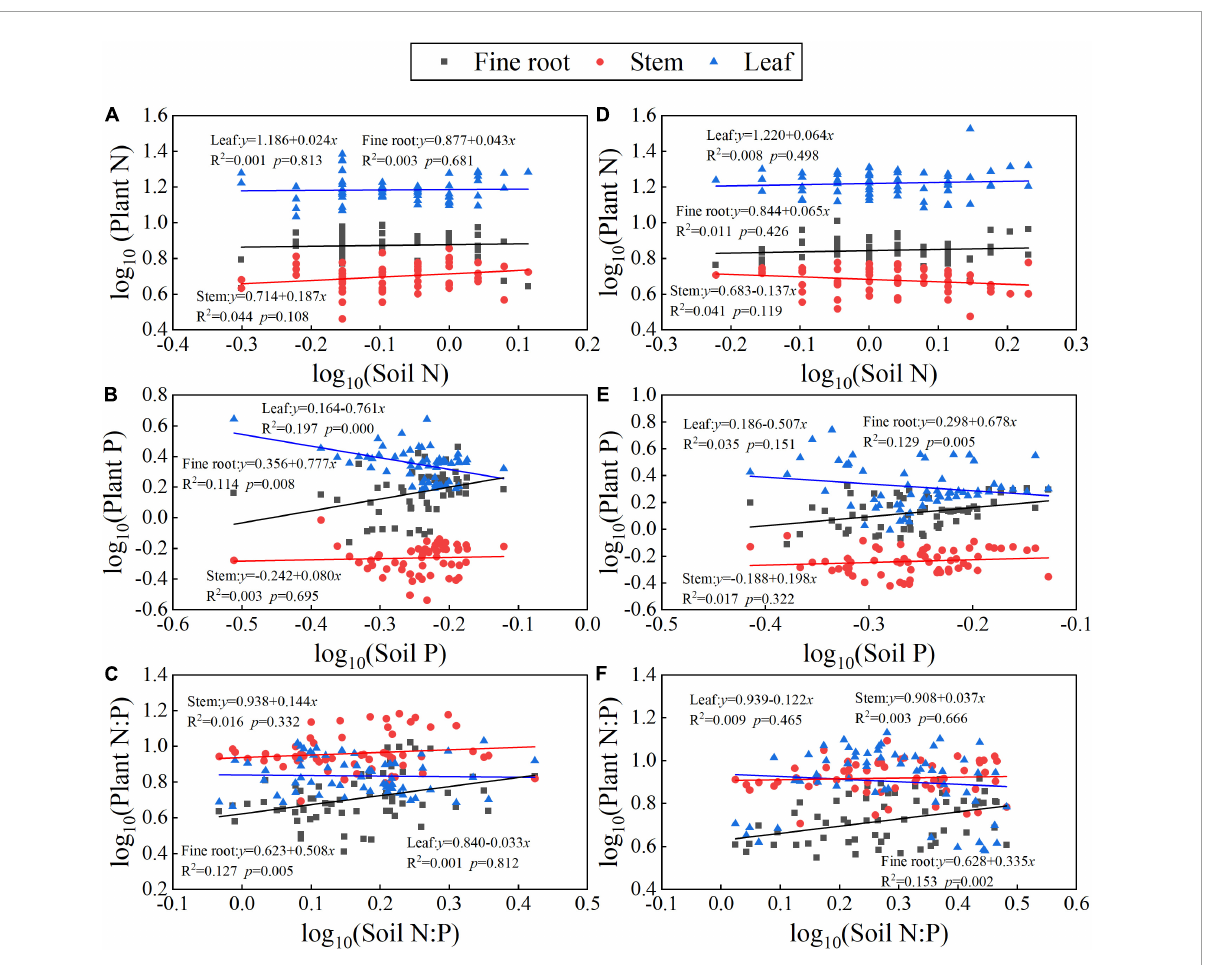
FIGURE7 The N, P, and N:P stoichiometric homeostasis coefficients between fine roots, stems, and leaves of Taxodium ascendens (A–C) and Taxodium distichum (D–F) .